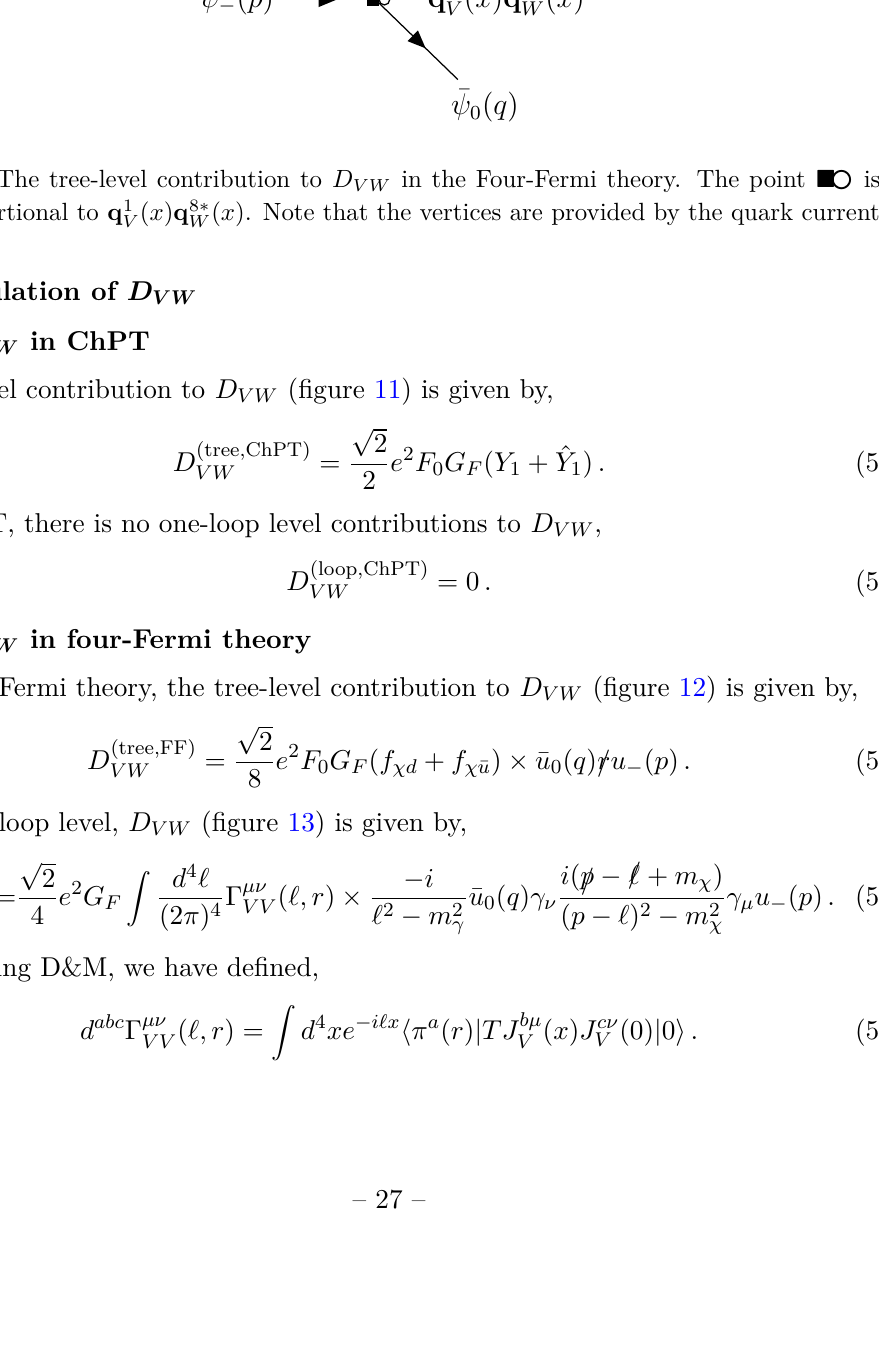
Figure 11 . The tree-level contribution to D V W in the ChPT. The point (cid:4) tional to q 1 ( x ) q 8 ∗ ( x ) . V W